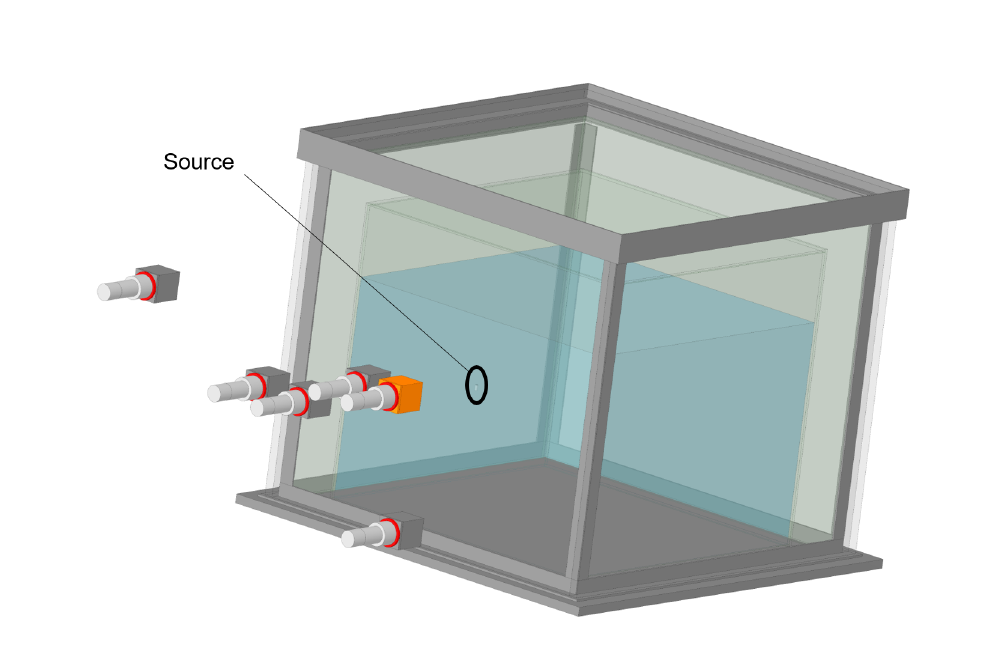
Figure 2: 3D representation of the Cf-252 source facility at Lancaster